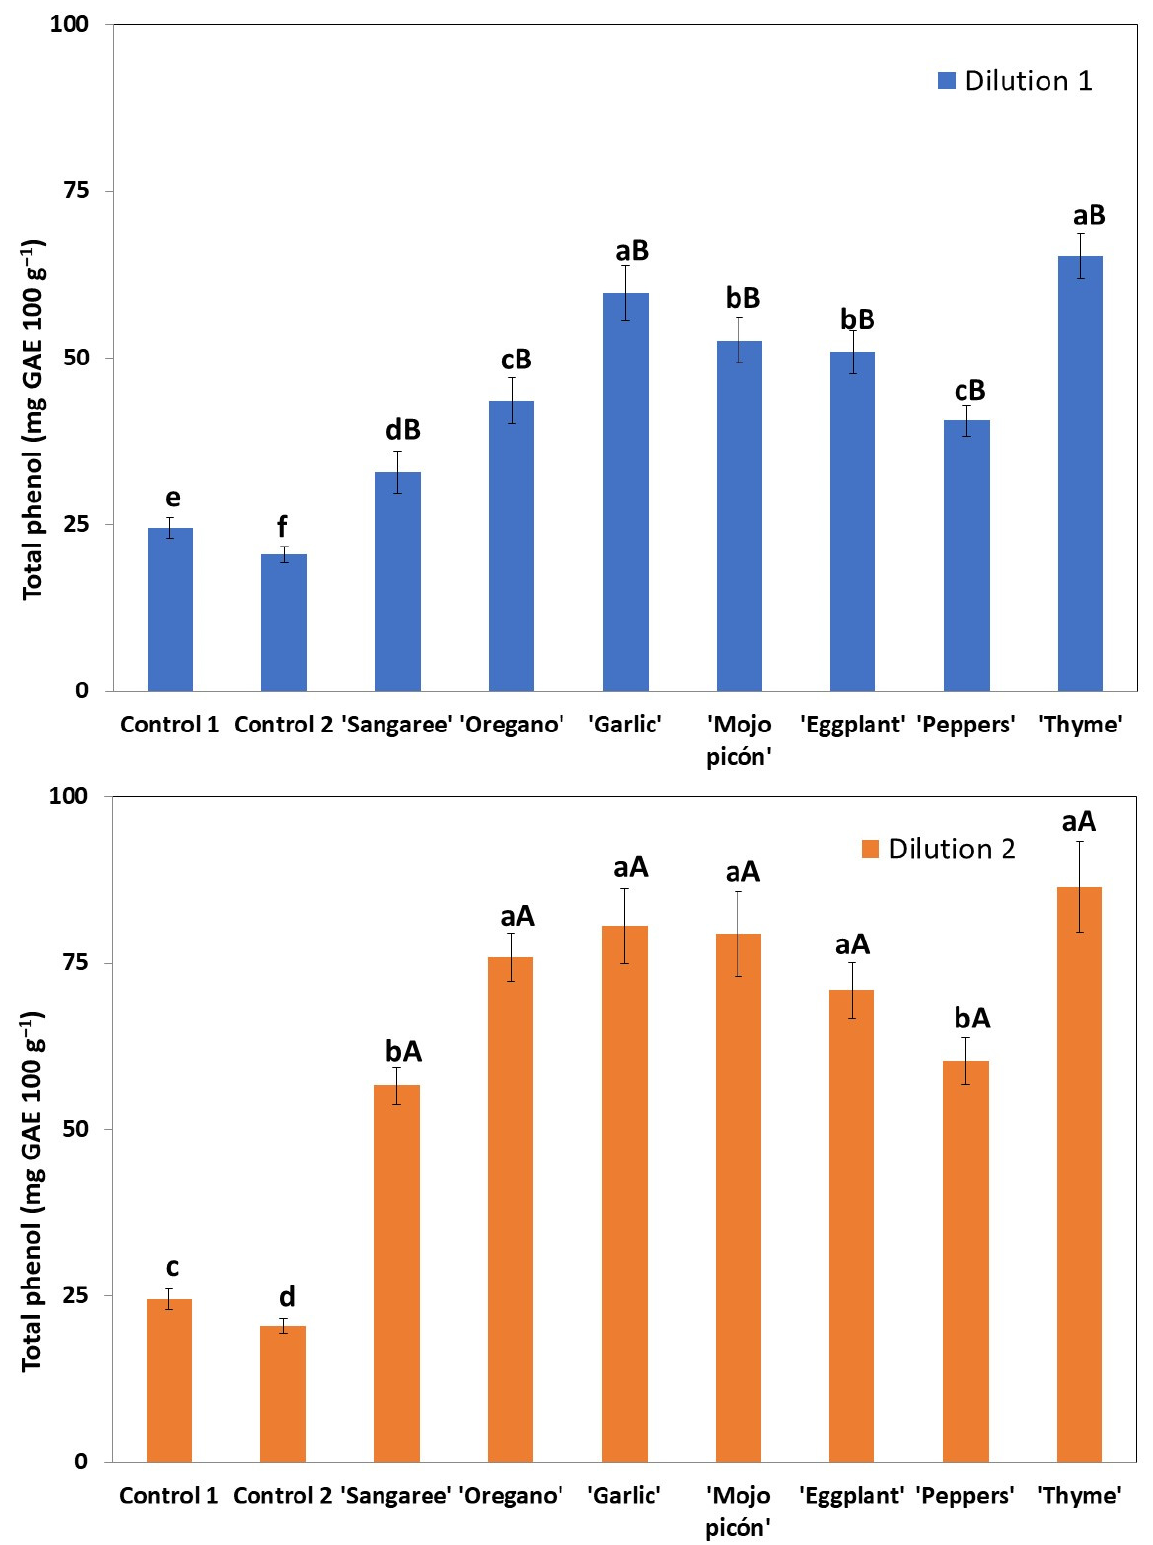
Figure 3. Total phenol (mg GAE 100 g − 1 ) of ‘Hojiblanca’ table olive variety stuffed with different aromatic hydrocolloids. Different lowercase letters mean a statistically significant difference between stuffed aromas (Tukey’s test p < 0.05 n = 3). Different capital letters mean significant differences between the different dilutions (Tukey’s test p < 0.05 n = 3).